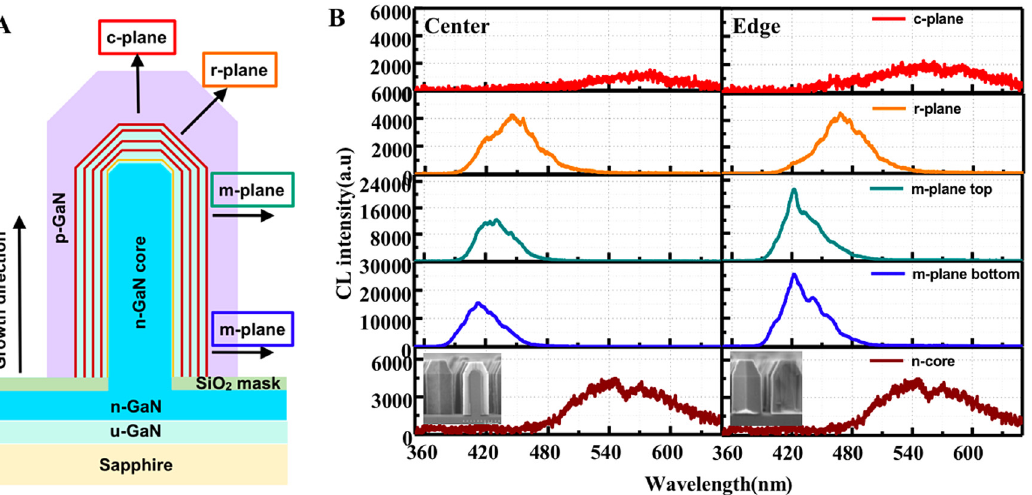
Figure 2: Cathodoluminescence (CL) spectra acquired at different areas of NWs in the sample a. (A) Cross-sectional schematic diagram of an NW indicating the CL measurement points. (B) CL spectra acquired on the c -plane at the apex region, the r -plane, and top and bottom areas on the m -plane of NWs at the center and edge area of the sample a. Insets show the cross- sectional view of SEM images of the NWs. The heights of NWs in the center and edge areas of the sample are 1.53 and 1.25 µm,